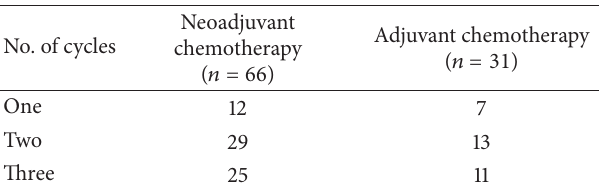
Table 2: Number of chemotherapy cycles completed by patients in the perioperative period.